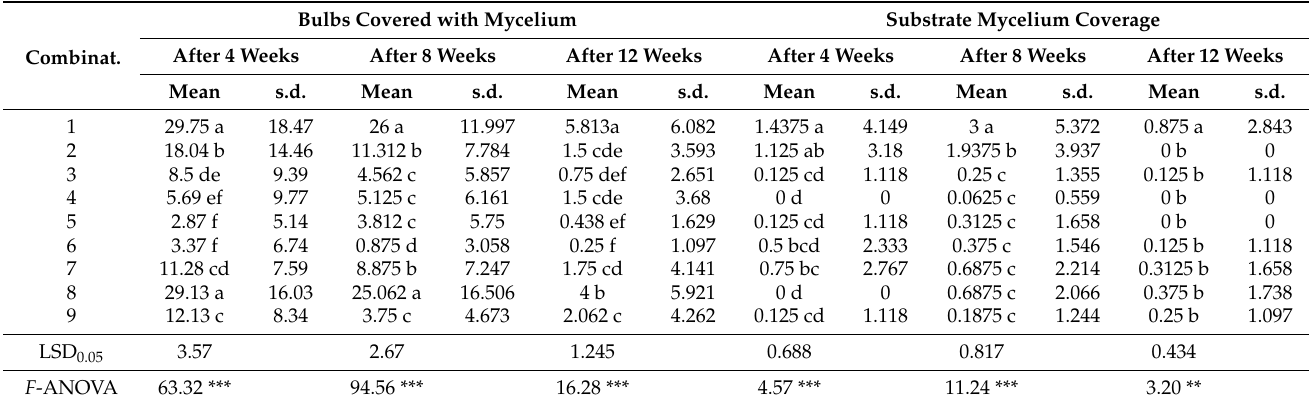
Table 2. Results of one-way analysis of variance, mean values and standard deviations (s.d.), as well as homogeneous groups for observed traits.